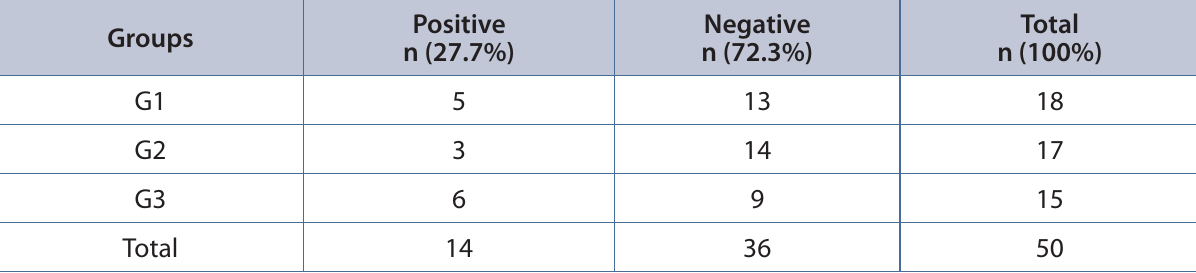
Table 3. Distribution of HIV/AIDS patients according to clinical and laboratory characteristics (n = 14) Patient Group